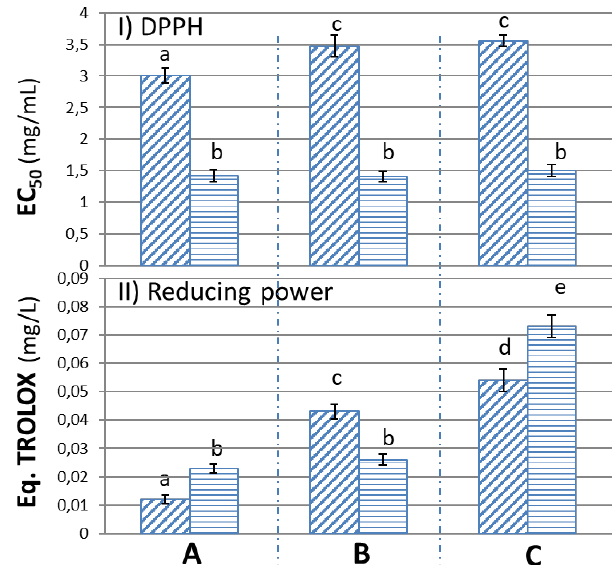
Figure 3. Activities determined by DPPH ( I ) and reducing power ( II ) methods of each phenolic extract obtained by solvent (oblique lines) or resin (horizontal lines). Methods I and II were carried out using the three samples obtained from di ff erent depths of the pond (upper A , middle B and lower C ). Means with the same letters were not significantly di ff erent, p <